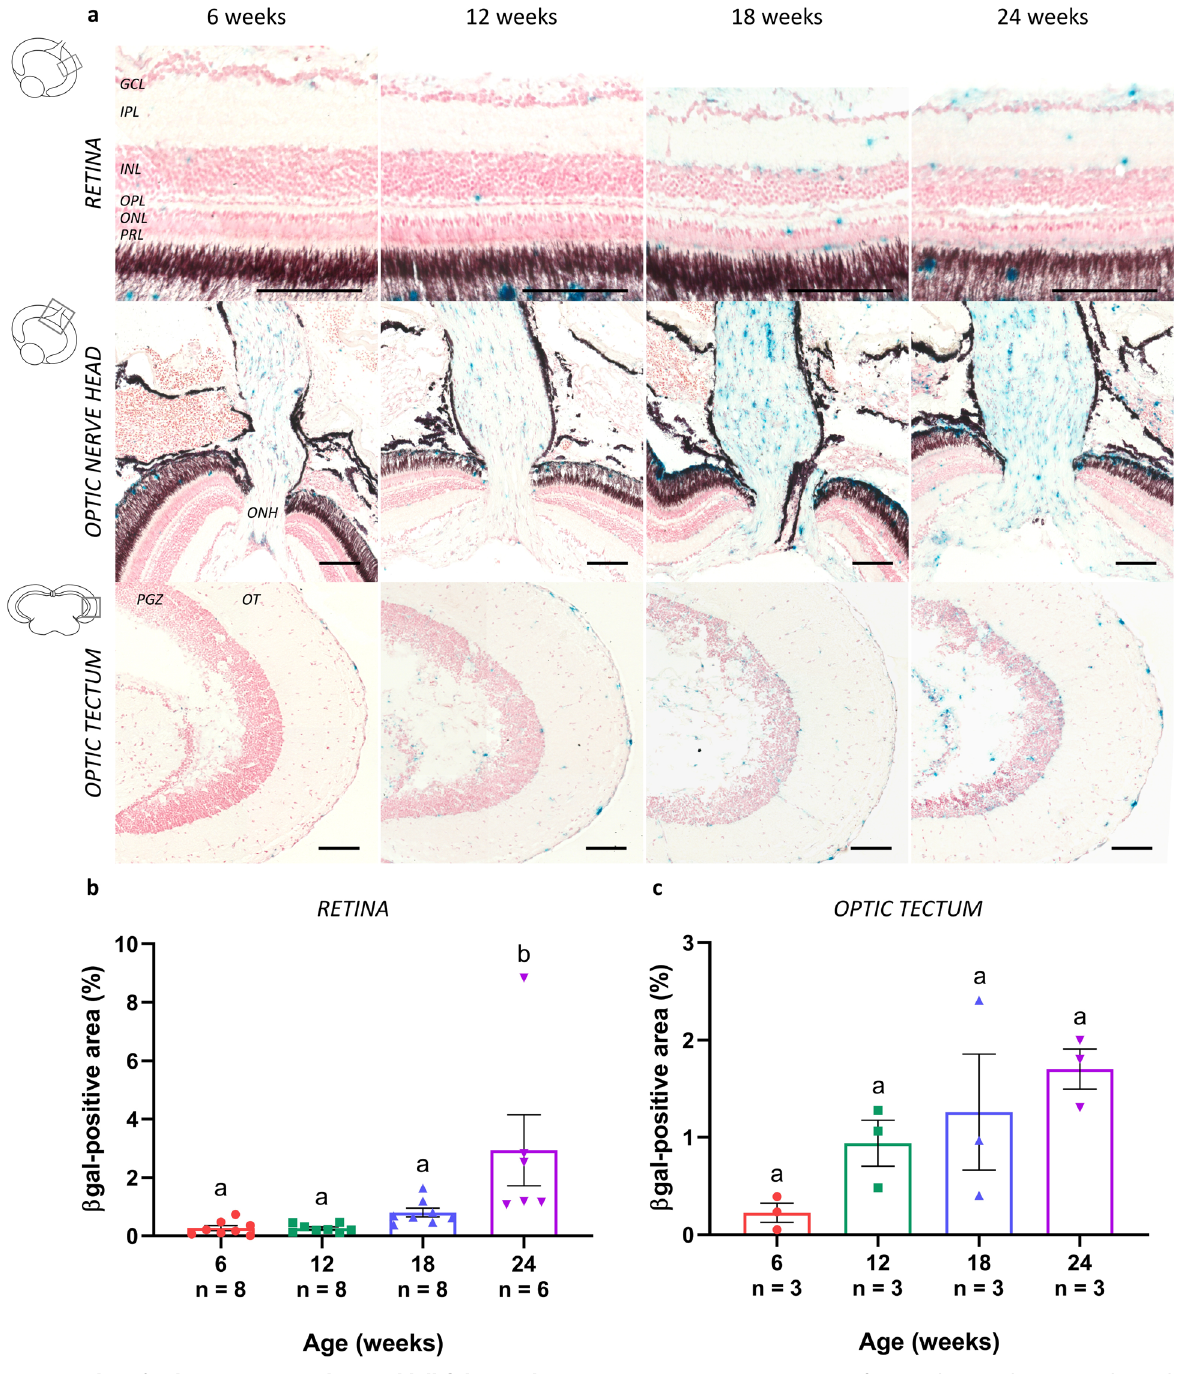
Fig. 4 Increased SA- β gal expression in the aged killi fi sh visual system. a Representative images of SA- β gal-stained sections show elevated expression levels of this lysosomal enzyme in the aged retina, optic nerve head, and brain. Whereas sections of 6-week-old fi sh are only scarcely labeled, increased expression levels are detected from 12 weeks onward. Note that these labeled cells are likely glial cells that are senescent. Scale bar = 100 µm. Quanti fi cation of the area occupied by SA- β gal-positive labeling demonstrates an age-associated upregulation in the neuroretina ( b ) as well as optic tectum ( c ) of the killi fi sh. Values are shown as mean ± standard error of mean, n ≥ 3, statistical signi fi cance between different age groups is indicated using different letters. SA- β gal senescence-associated β -galactosidase, GCL ganglion cell layer, IPL inner plexiform layer, INL inner nuclear layer, OPL outer plexiform layer, ONL outer nuclear layer, PRL photoreceptor segment layer, ONH optic nerve head, PGZ periventricular gray zone, OT optic fi sh (Fig. 6a; magni fi ed boxes). Quanti fi cation of the L-plastin- and was signi fi cantly elevated in the optic tectum (Fig. 6c). Next, to changes in their cell number and morphology, microglia in the immunopositive area within a prede fi ned region in the retina and aging vertebrate brain also typically display a senescence- tectum revealed that, with advancing age, the area occupied by associated secretory phenotype (SASP), with increases in microglia/macrophages tended to increase in the retina (Fig. 6b)